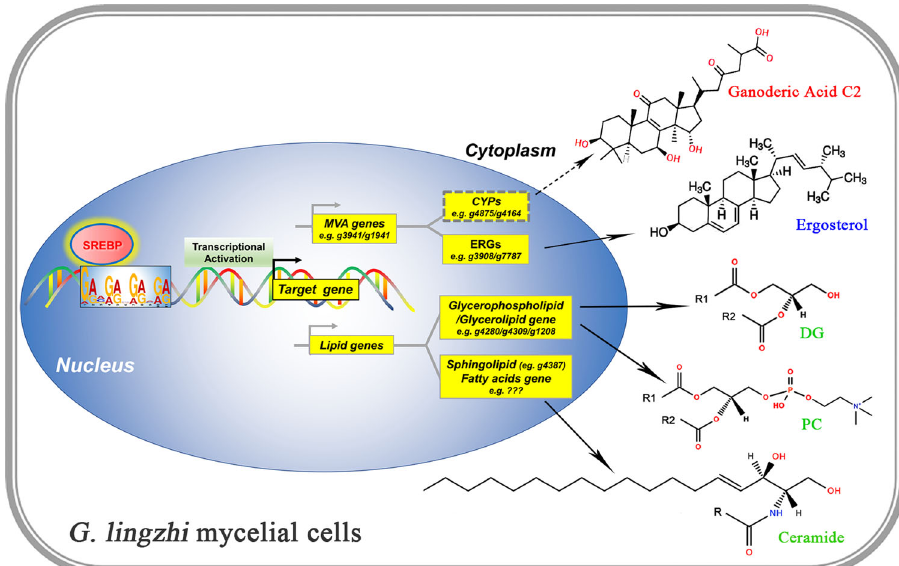
Fig. 6 Model depicting the mechanisms of SREBP in enhancing GAs, ergosterol and lipid biosynthesis in G. lingzhi . The bHLH-zip transcription factor SREBP interacts directly with the promoter binding sites (the best- fi t motif 5 ′ -GRVGRVGRVGR-3 ′ is shown) of SREBP targes. SREBP promoted the transcription of its target genes that are involved in GAs, ergosterol and lipid biosynthesis. The key target genes g3941 / g1941 encoding mevalonate kinase/ 3-hydroxy-3-methylglutaryl CoA synthetase, g4875 / g4164 encoding CYPs, g7787 / g3908 encoding sterol isomerase/lanosterol 14-demethylase, g4280 / g4309 / g1208 encoding cardiolipin-speci fi c phospholipase/ lysophospholipid acyltransferase/ethanolamine-phosphotransferase, and g4387 encoding ceramide synthase, involved in MVA pathway, GAs biosynthesis, ergosterol biosynthesis, glycerolipid/glycerophospholipid biosynthesis, and sphingolipids biosynthesis, respectively, are displayed in the corresponding position. Two uncharacterized SREBP target CYPs, g4875 and g4164 , which possible involved in GA biosynthesis, marked by dotted line. The representative GAs (GA-C2), ergosterol, glycerolipid (DG), glycerophospholipid (PC), and sphingolipid (ceramide) are displayed. R, R1, and R2 indicate fatty